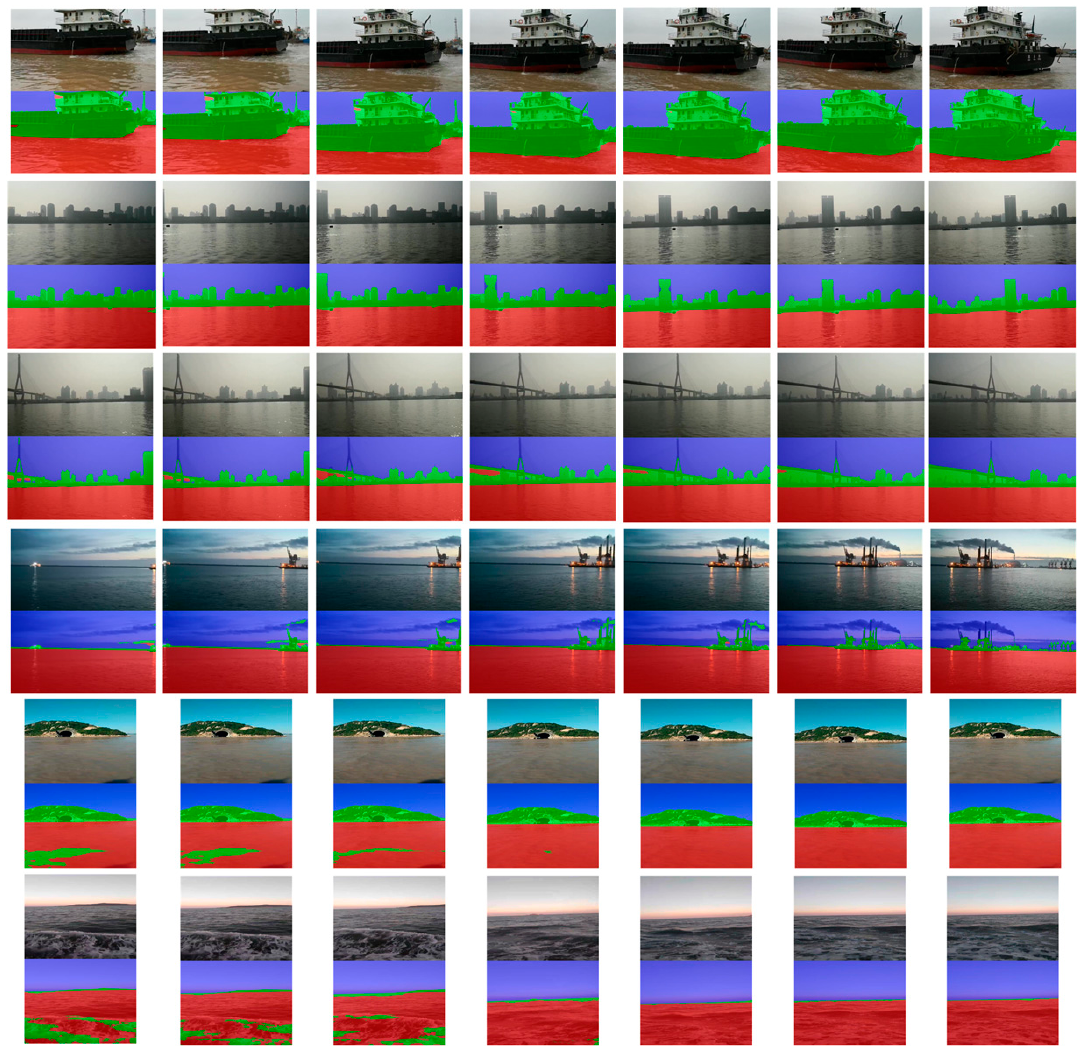
Figure 8. Model transferred to a new environment.